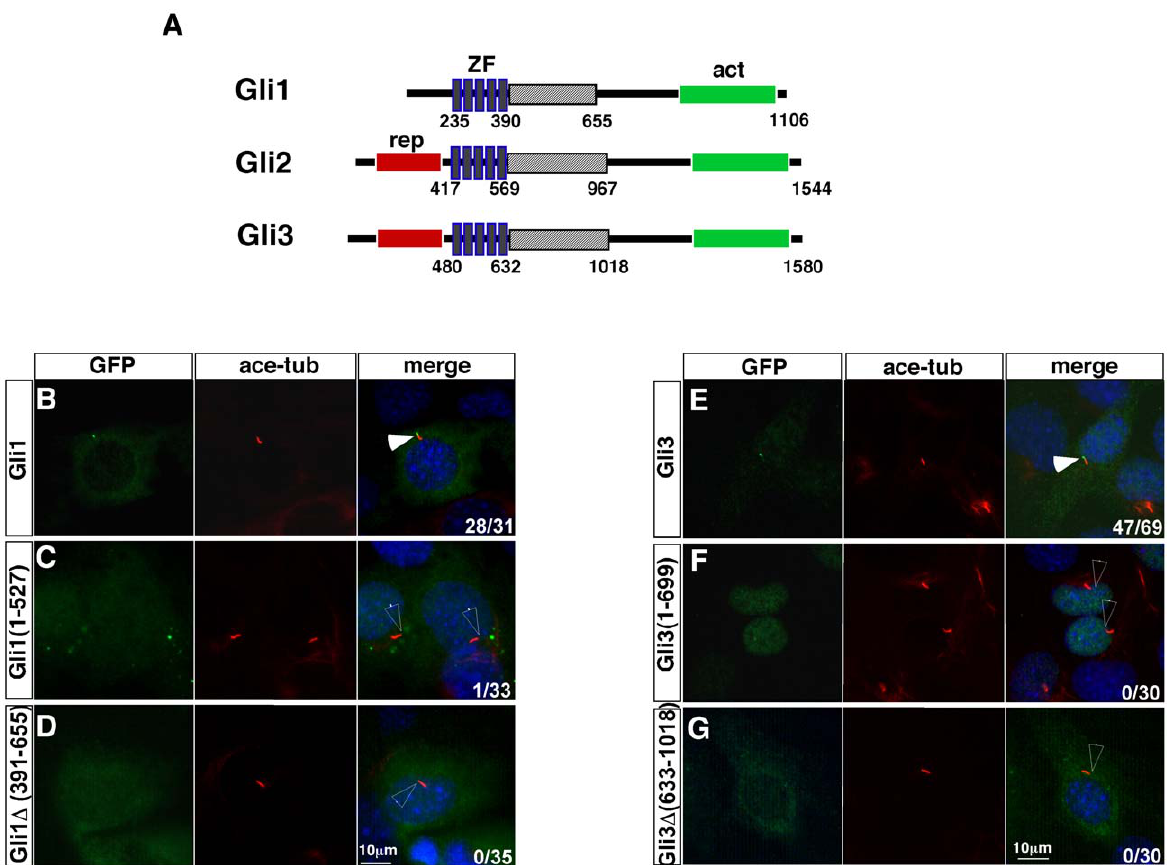
Figure 2. The central regions of Gli1 and Gli3 are essential for their ciliary localization. (A) Schematic illustrations of the three Gli proteins. The repressor domains (rep: red box) are present in Gli2 and Gli3, but not Gli1, although the activator domains (act: green box) are present in all three Gli proteins. The central regions immediately C-terminal to the zinc fingers (ZF) are shown as striped boxes. (B) GFP-Gli1 is localized to the tips of cilia when over-expressed in the ciliated mouse MEFs. (C) Gli1(1–527) is not localized to the cilia. (D) GFP-Gli1 D (391–655) is not localized to the cilia. (E) Gli3 is localized to the tips of cilia. (F) Gli3 (1–699) is not localized to the cilia. (G) Gli3 D (633–1018) is not localized to the cilia. Immunofluorescent images of MEFs transfected with GFP-tagged Gli1 and Gli3 variants are shown. Cilia are labeled with acetylated tubulin and nuclei are stained with DAPI. In the merged images, filled arrowheads indicate GFP-Gli proteins at the tips of the cilia, unfilled arrowheads indicate the tips of cilia without GFP-Gli protein accumulation. Numbers at the lower-right corners of each image indicate numbers of cells with ciliary localization of GFP-tagged proteins over total numbers of transfected cells.